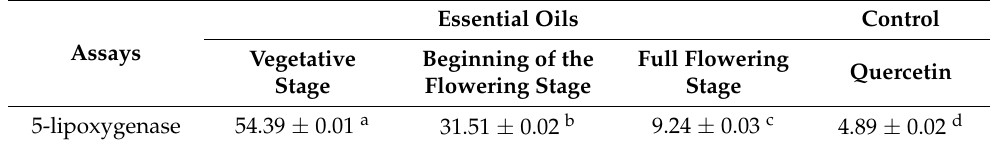
Table 5. The anti-inflammatory activity of SOEO (IC 50 in µ g/mL) at three developmental